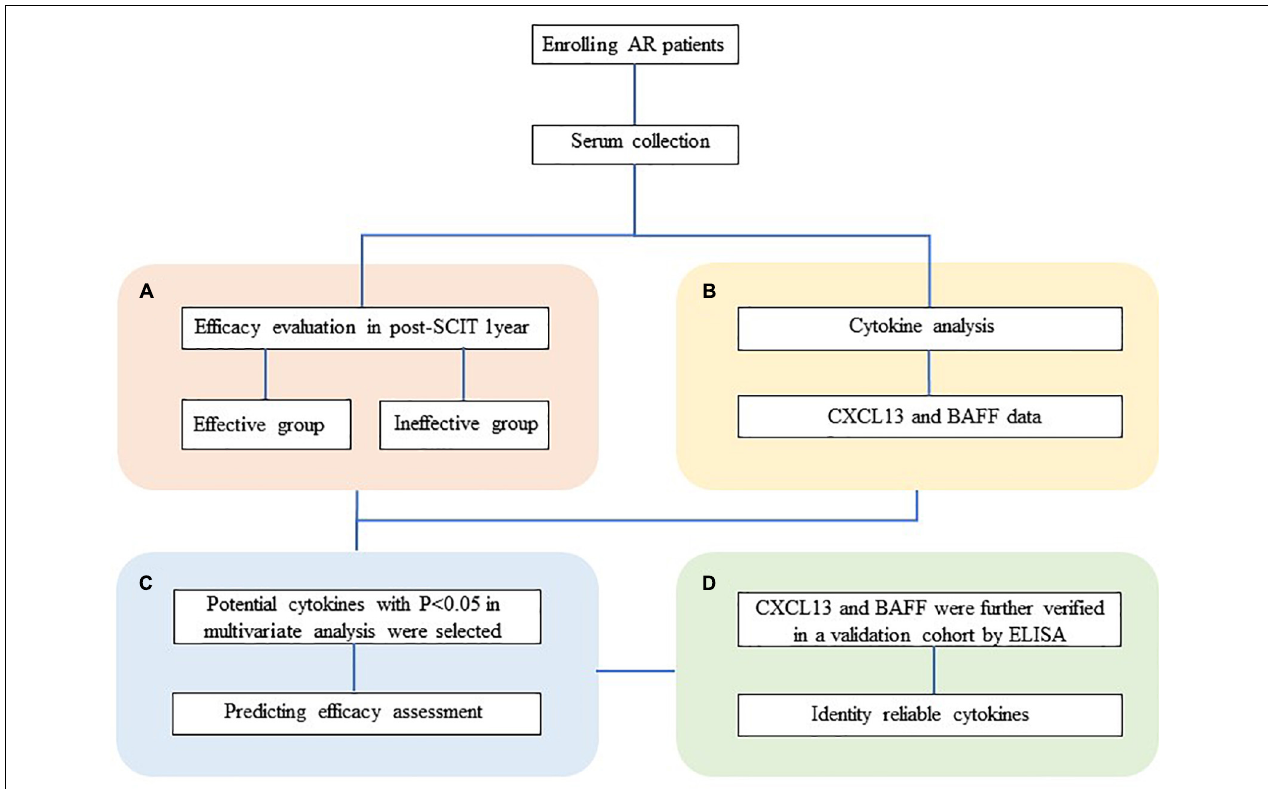
FIGURE 1 | Overview of studies exploring serum predictive biomarkers of SCIT efficacy in patients with HDM-induced AR. (A) Follow-up and efficacy assessment. (B) The analysis of CXCL13 and BAFF levels in serum was performed by ELISA. (C) Cytokine levels were compared between the effective and ineffective groups, and their predictive ability was assessed. (D) Serum CXCL13 and BAFF are further validated by ELISA in a validation cohort. HDM, house dust mite; AR, allergic rhinitis; SCIT, subcutaneous immunotherapy; ELISA, enzyme-linked immunosorbent assay; CXCL13, C-X-C motif ligand 13; BAFF, B cell-activating factor.